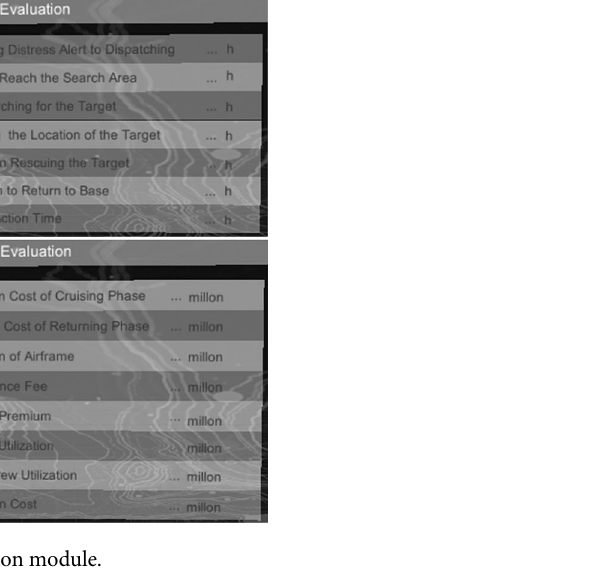
Figure 9. Comprehensive evaluation